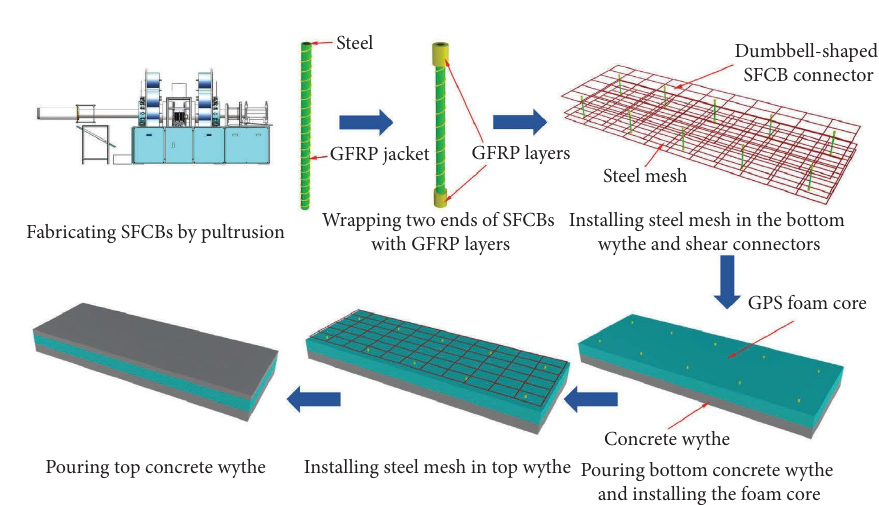
Figure 1: Fabrication procedure of insulated sandwich panels using dumbbell-shaped SFCB connectors.